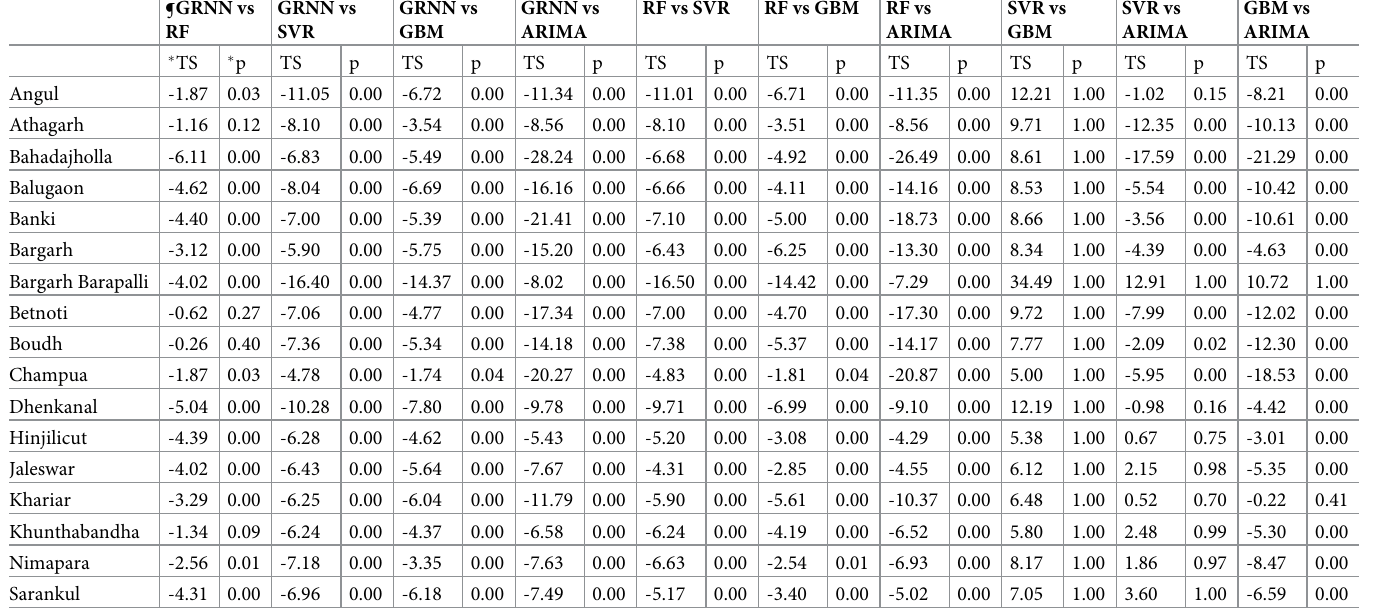
Table 6. Diebold Mariano test